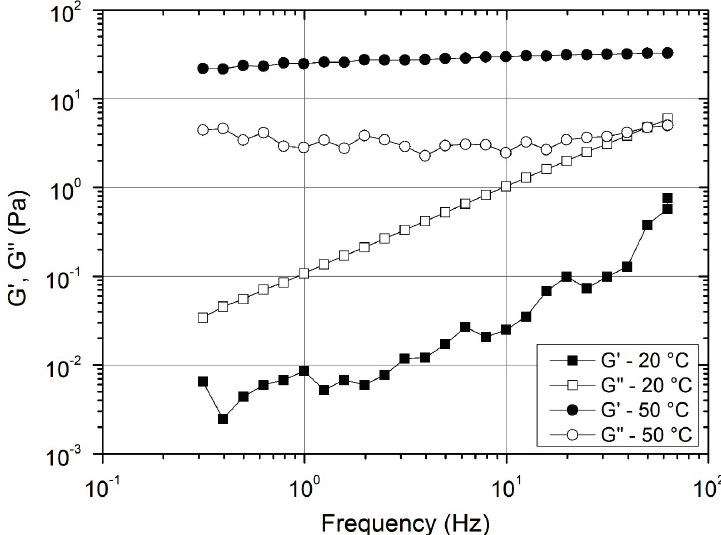
Figure 7. Dynamic behavior of methylcellulose A15C at 10 g/L in aqueous solution. G ' filled symbols (at 20 °C, the values remain difficult to determine due to their magnitude around 10 − 2 Pa), G '' open symbols. The lines are added to guide the eye.